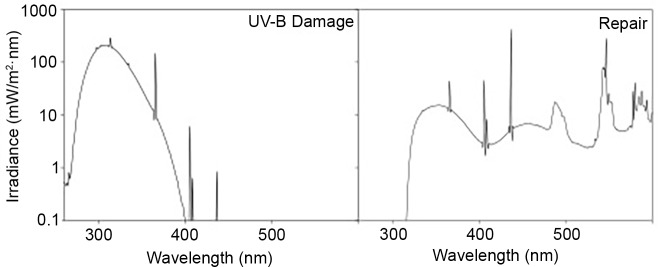
Emission spectra.The emission spectra for the lamp system used to induce DNA damage (left, UV-B Damage) and to photoreactivate damage after induction (right, Repair). This lamp design has been used in many laboratory-based UV studies of freshwater species and has been found to be highly applicable and comparable to what is observed in natural systems (e.g. [15] and its references).